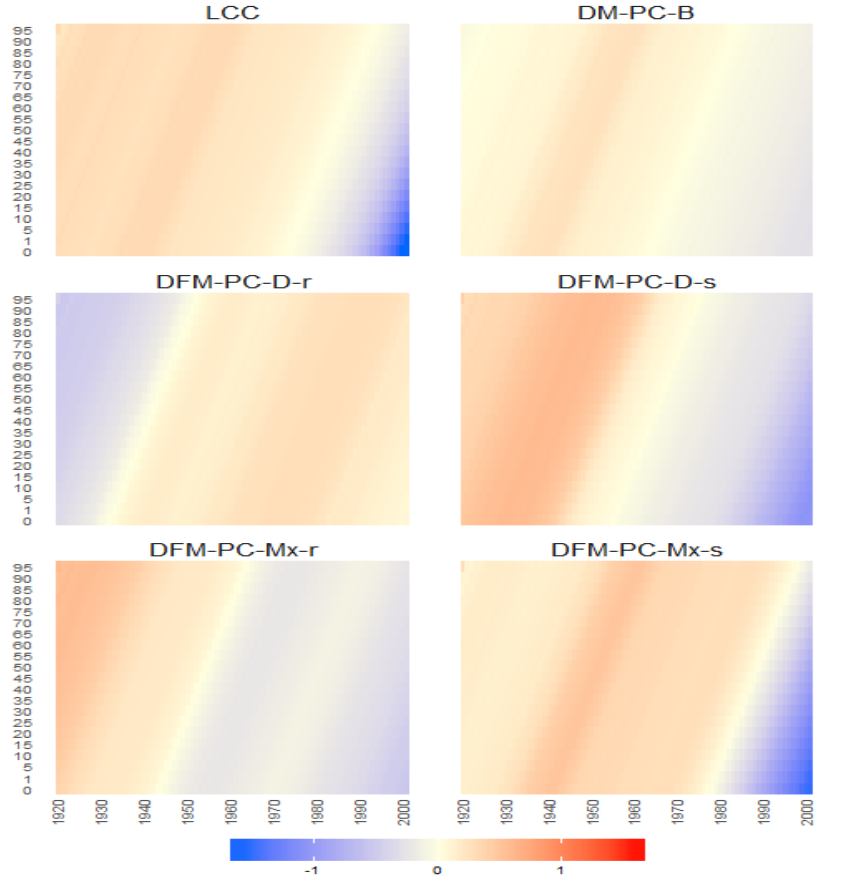
Figure 34. The Bayesian posterior mean estimates for the cohort effect latent processes vector γ t across age groups (y axis) over time (x axis) under different models for British female log death rates during